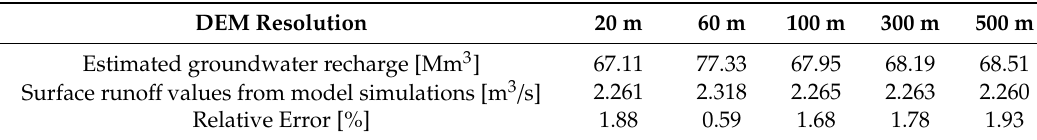
Results of the application of the inverse hydrogeological balance to the case study—evapotranspiration calculated with Budyko formulation.